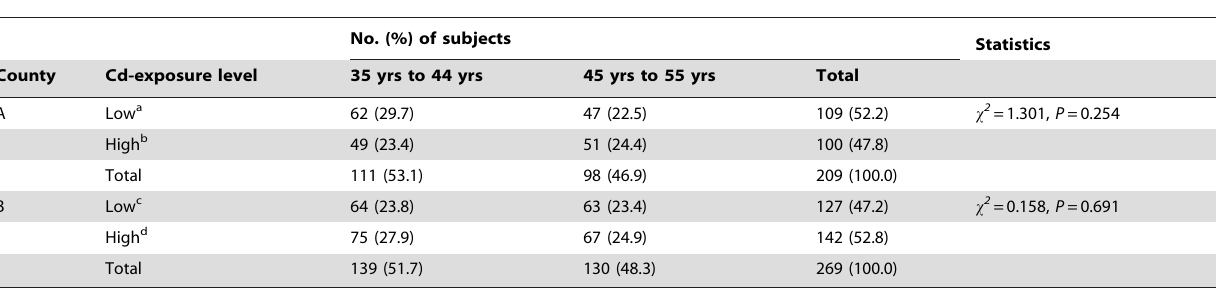
Table 1. Age distribution of subjects enrolled from CA and CB.